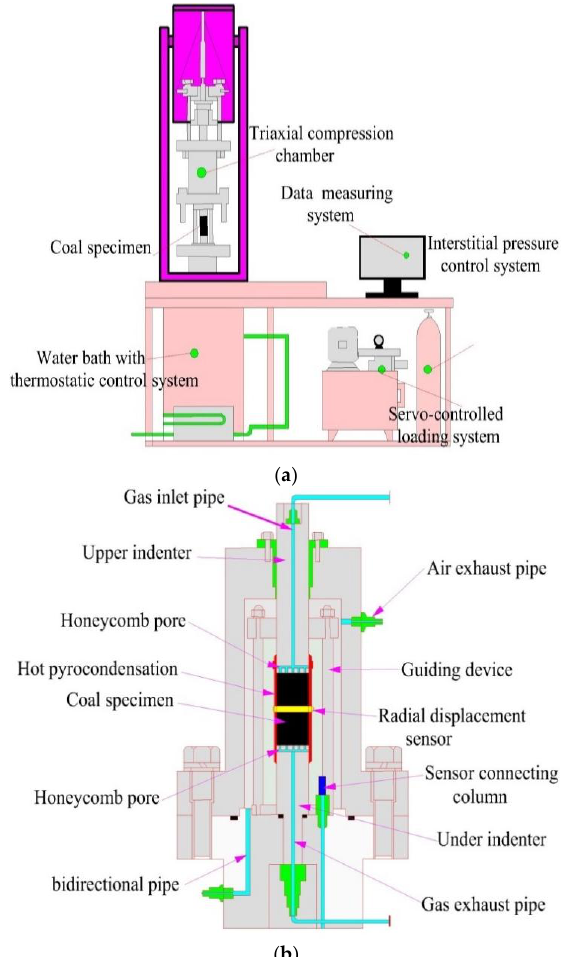
Figure 3. The triaxial servo-controlled seepage equipment for thermo-fluid-solid coupling of gas-bearing coal. ( a ) Schematic diagram; ( b ) Schematic diagram of the triaxial